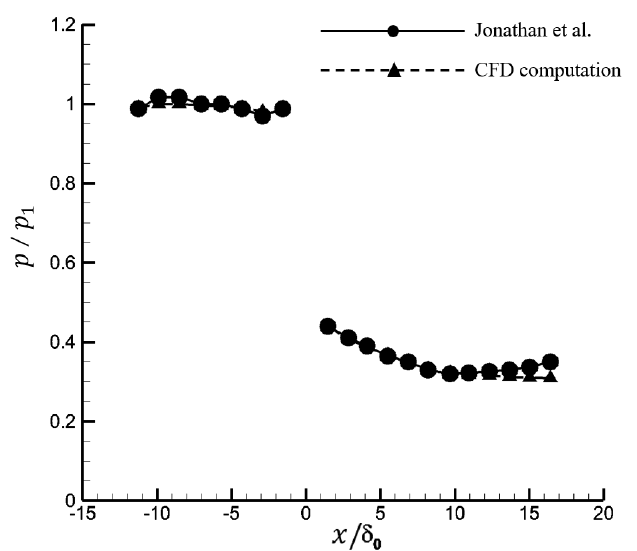
Figure 3. Normalized pressure p along the flow direction on the wall ( p 1 is the pressure in the freestream).